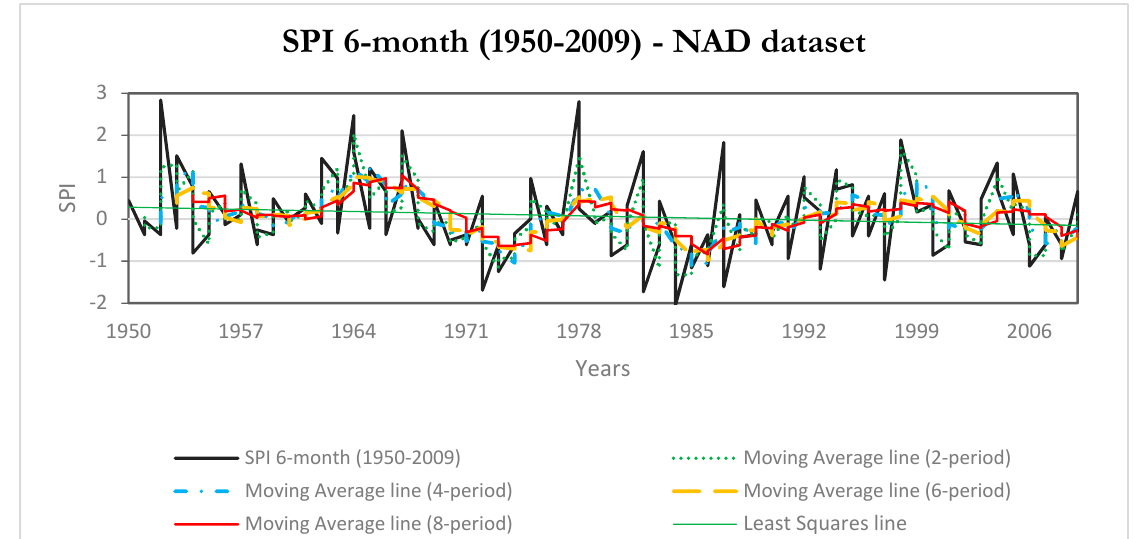
Figure 4. SPI 6-month (1950–2009) with tendency lines (Least Squares line and Moving average: 2-, 4-, 6-, 8-period)—NAD dataset.